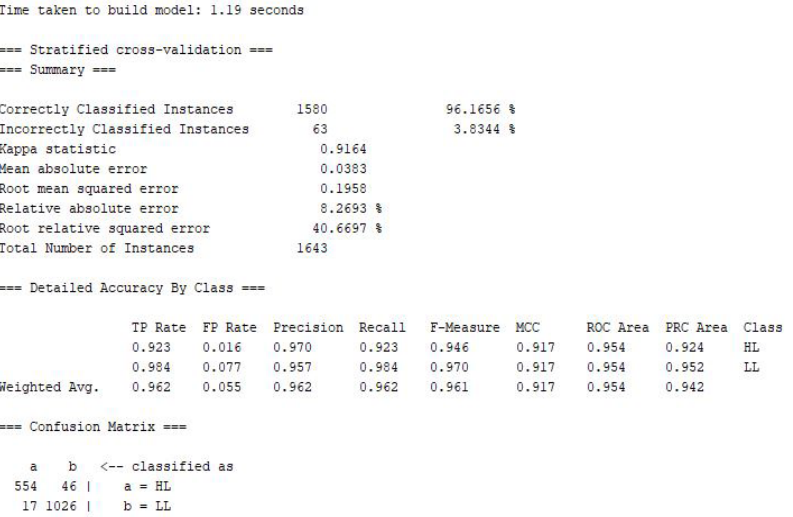
Figure 6: Sequential minimal optimisation (SMO) model for training